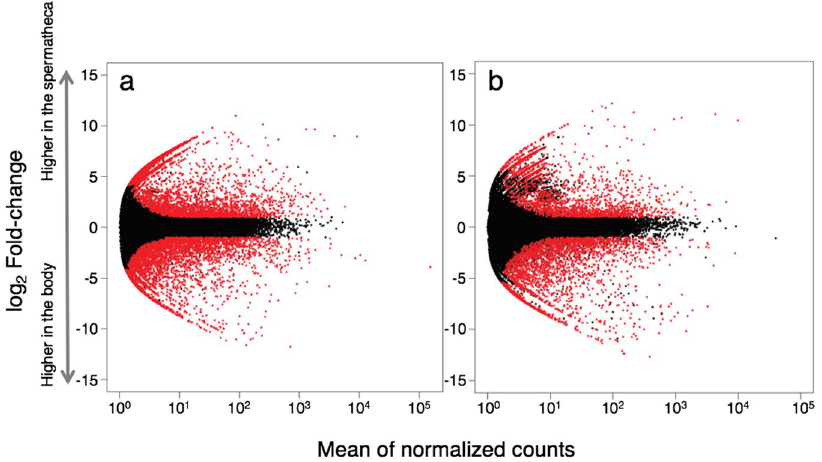
Figure 2. Plots of differentially expressed genes between the spermatheca and the body samples at 1 week ( a ) and 1 year ( b ) after mating. Red dots indicate differentially expressed genes with false discovery rates (FDR) of < 0.01and |log ≥ 2 fold change|